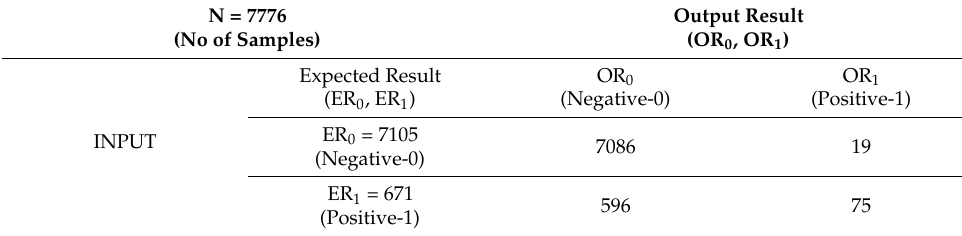
Table 11. SVM testing